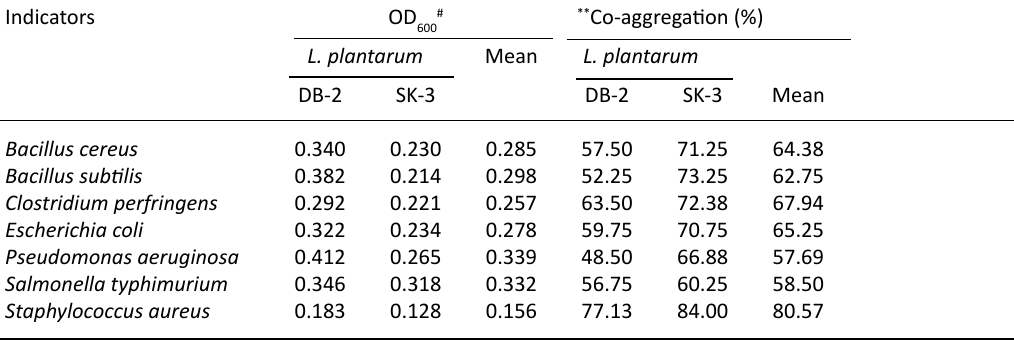
Table 7. Evaluation of Co-aggregation ability of L. plantarum DB-2 and SK-3 with test indicators Indicators OD 600# ** Co-aggregation (%) L. plantarum